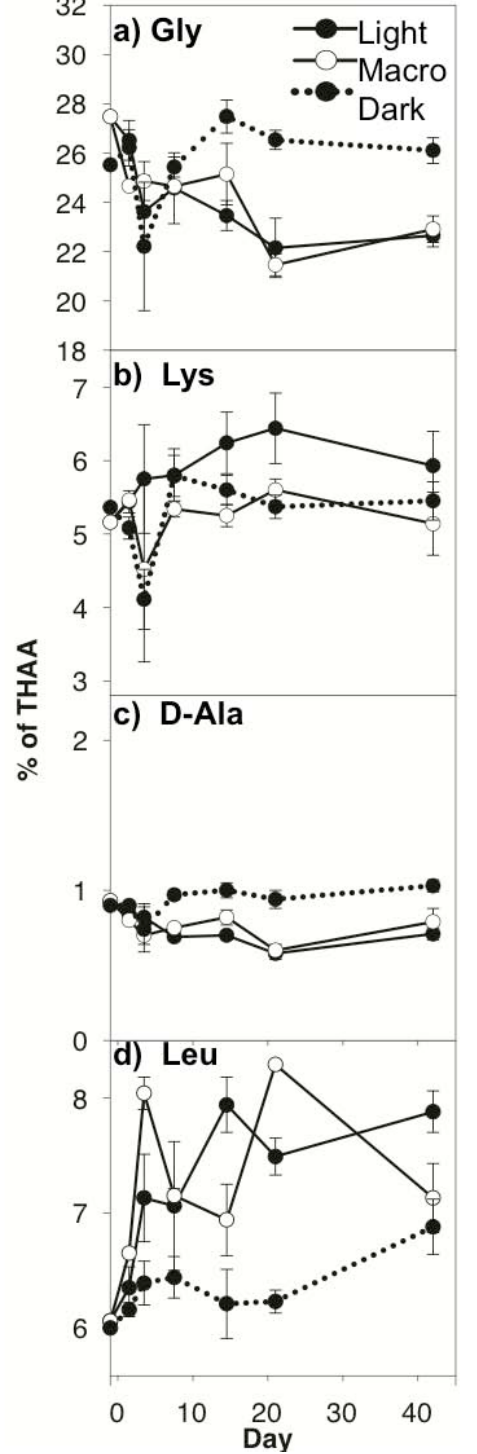
Fig. 4. Composition as mole percent of THAA for select HAA in surface (0–1cm) sediments: (a) glycine, (b) lysine, (c) D-alanine, and (d) leucine. Note scale differences between graphs. Values are mean ± SE ( n = 4).